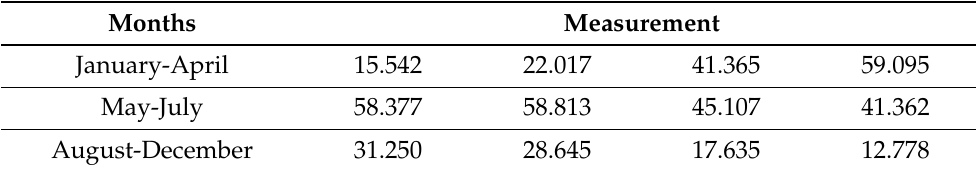
Table 1. Observed value u ( f ) for the US-ARM